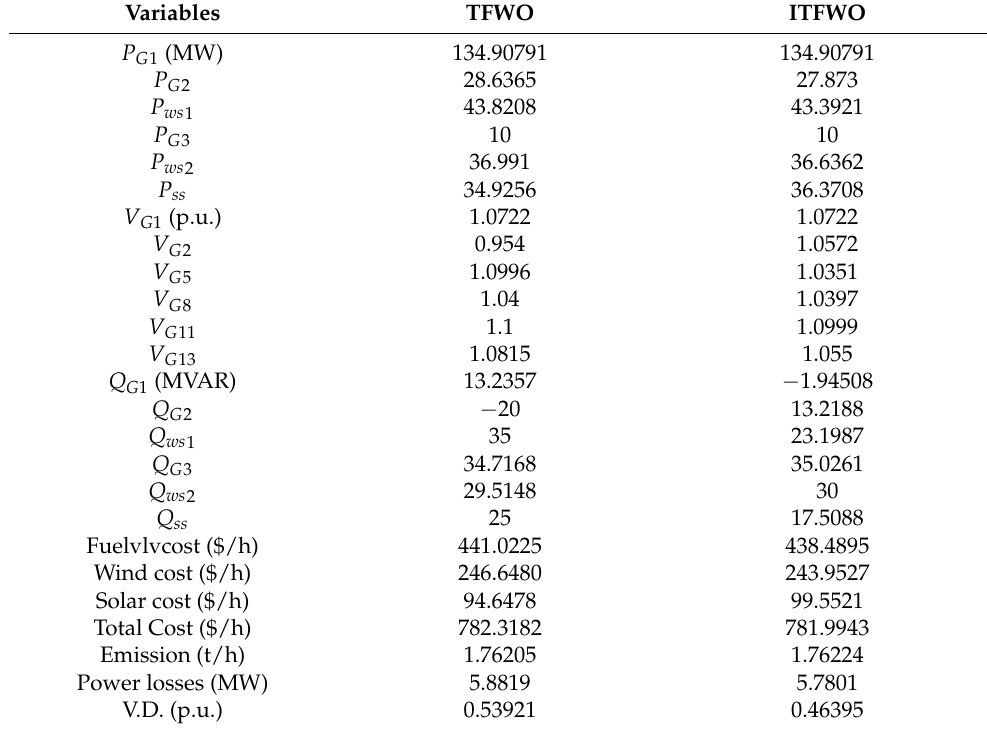
Table 8. The optimization results for Type